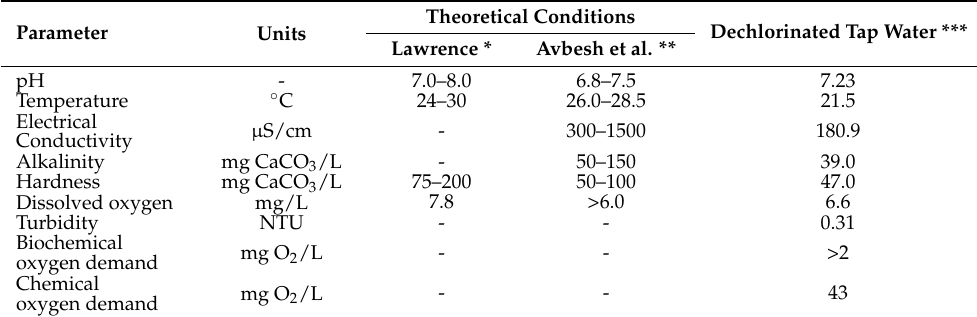
Table 1. Comparison of the appropriate theoretical conditions of water for zebrafish life and the physical–chemical and chemical properties of dechlorinated tap water (water used to maintain fish and dilute synthetic waters used in assays).